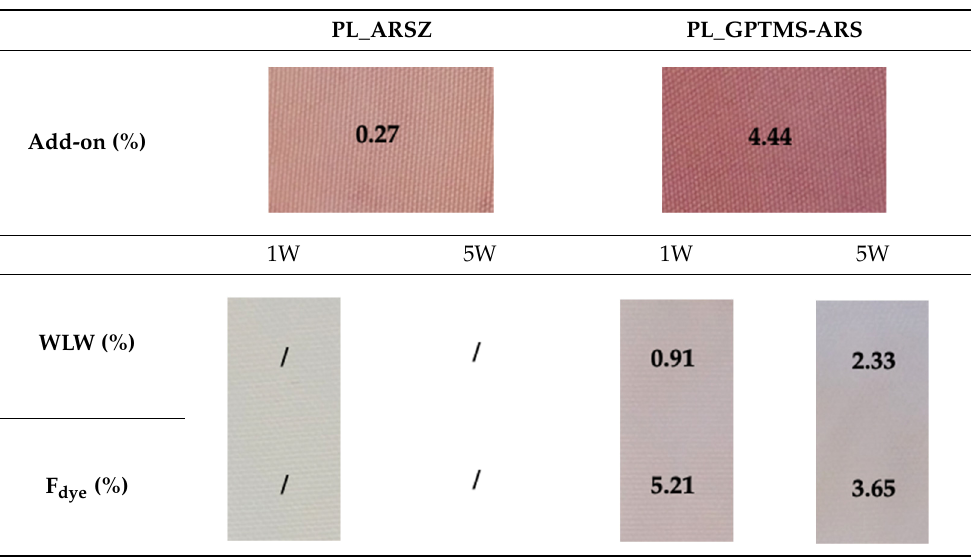
Table 1. Images and add-on (wt%), weight loss (WLW, wt%) and fixation ratio (F dye , %) data of textile fabrics treated with plain ARS solution and GPTMS-ARS sol calculated at the maxima absorbance wavelength as reported in the footnote ( 1 ).